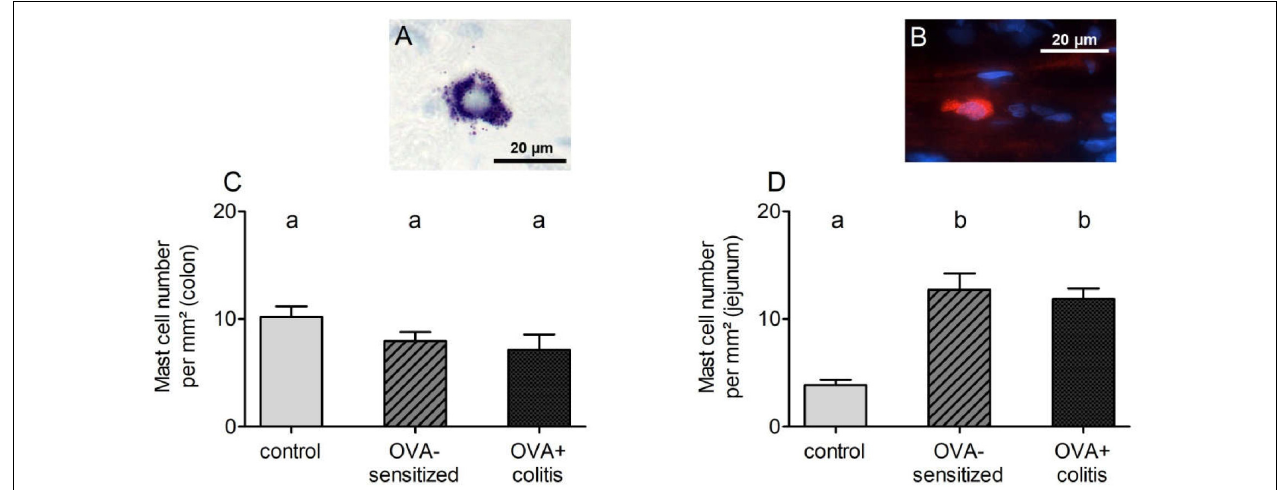
FIGURE 4 | Exemplary images of submucosal mast cells stained with toluidine blue ( A , from a control animal) or c-kit ( B , from a sensitized animal). Mast cell density (c-kit positive cells per mm 2 ) quantified in distal colon (C) or jejunum (D) . Data expressed as mean (bars) + SEM (lines), n = 9 sections analyzed with a total number of 152–530 mast cells. Statistically homogeneous groups are labeled with the same letter (a, b), thus all groups which do not share the same letter are significantly different from each other. P < 0.05 (ANOVA followed by LSD post hoc test).